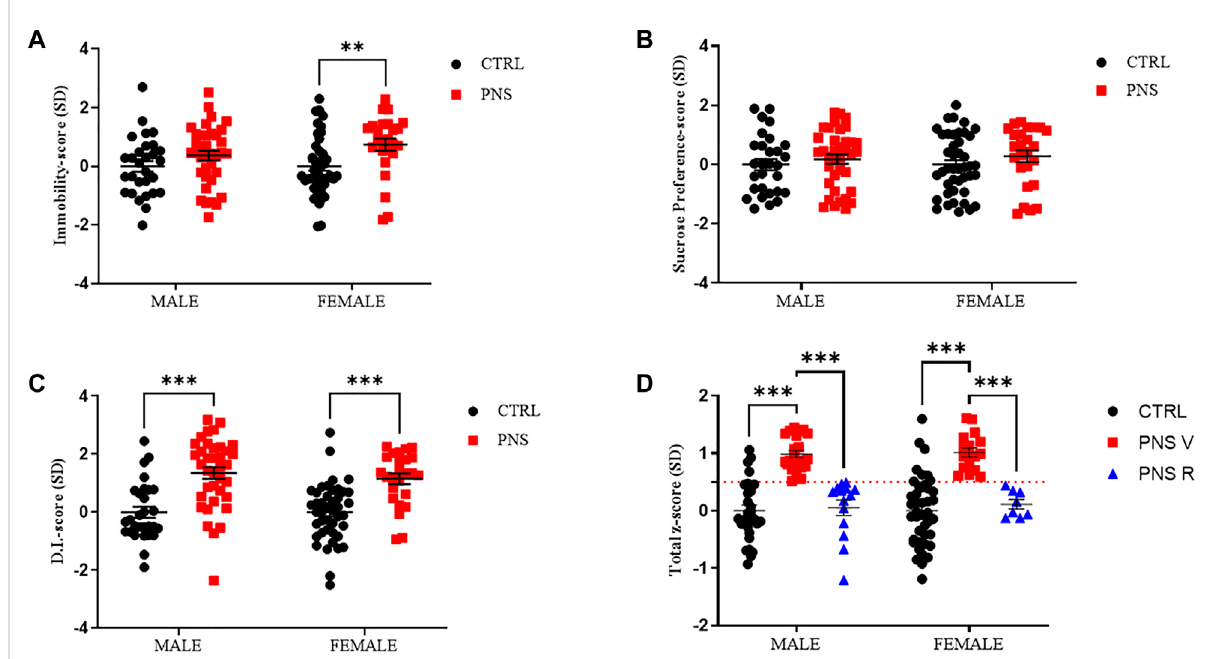
Identi fi cationofvulnerableandresilientratsbyapplyingz-scoremethod. (A) z-scorevaluesinCTRLandPNSmaleandfemaleadolescentratsin FST.** p < 0.01vs.CTRLfemale. (B) z-scorevaluesinCTRLandPNSmaleandfemaleadolescentratsinSPT. (C) z-scorevaluesinCTRLandPNSmale and female adolescent rats in NOR test. *** p < 0.001 vs. CTRL groups. (D) Total z-score = (Z-score FST + Z-score SPT + Z-score NOR)/3). Male PNS V = 62%, *** p < 0.001 vs. CTRL and PNS R; female PNS V = 68%, *** p < 0.001 vs. CTRL and PNS